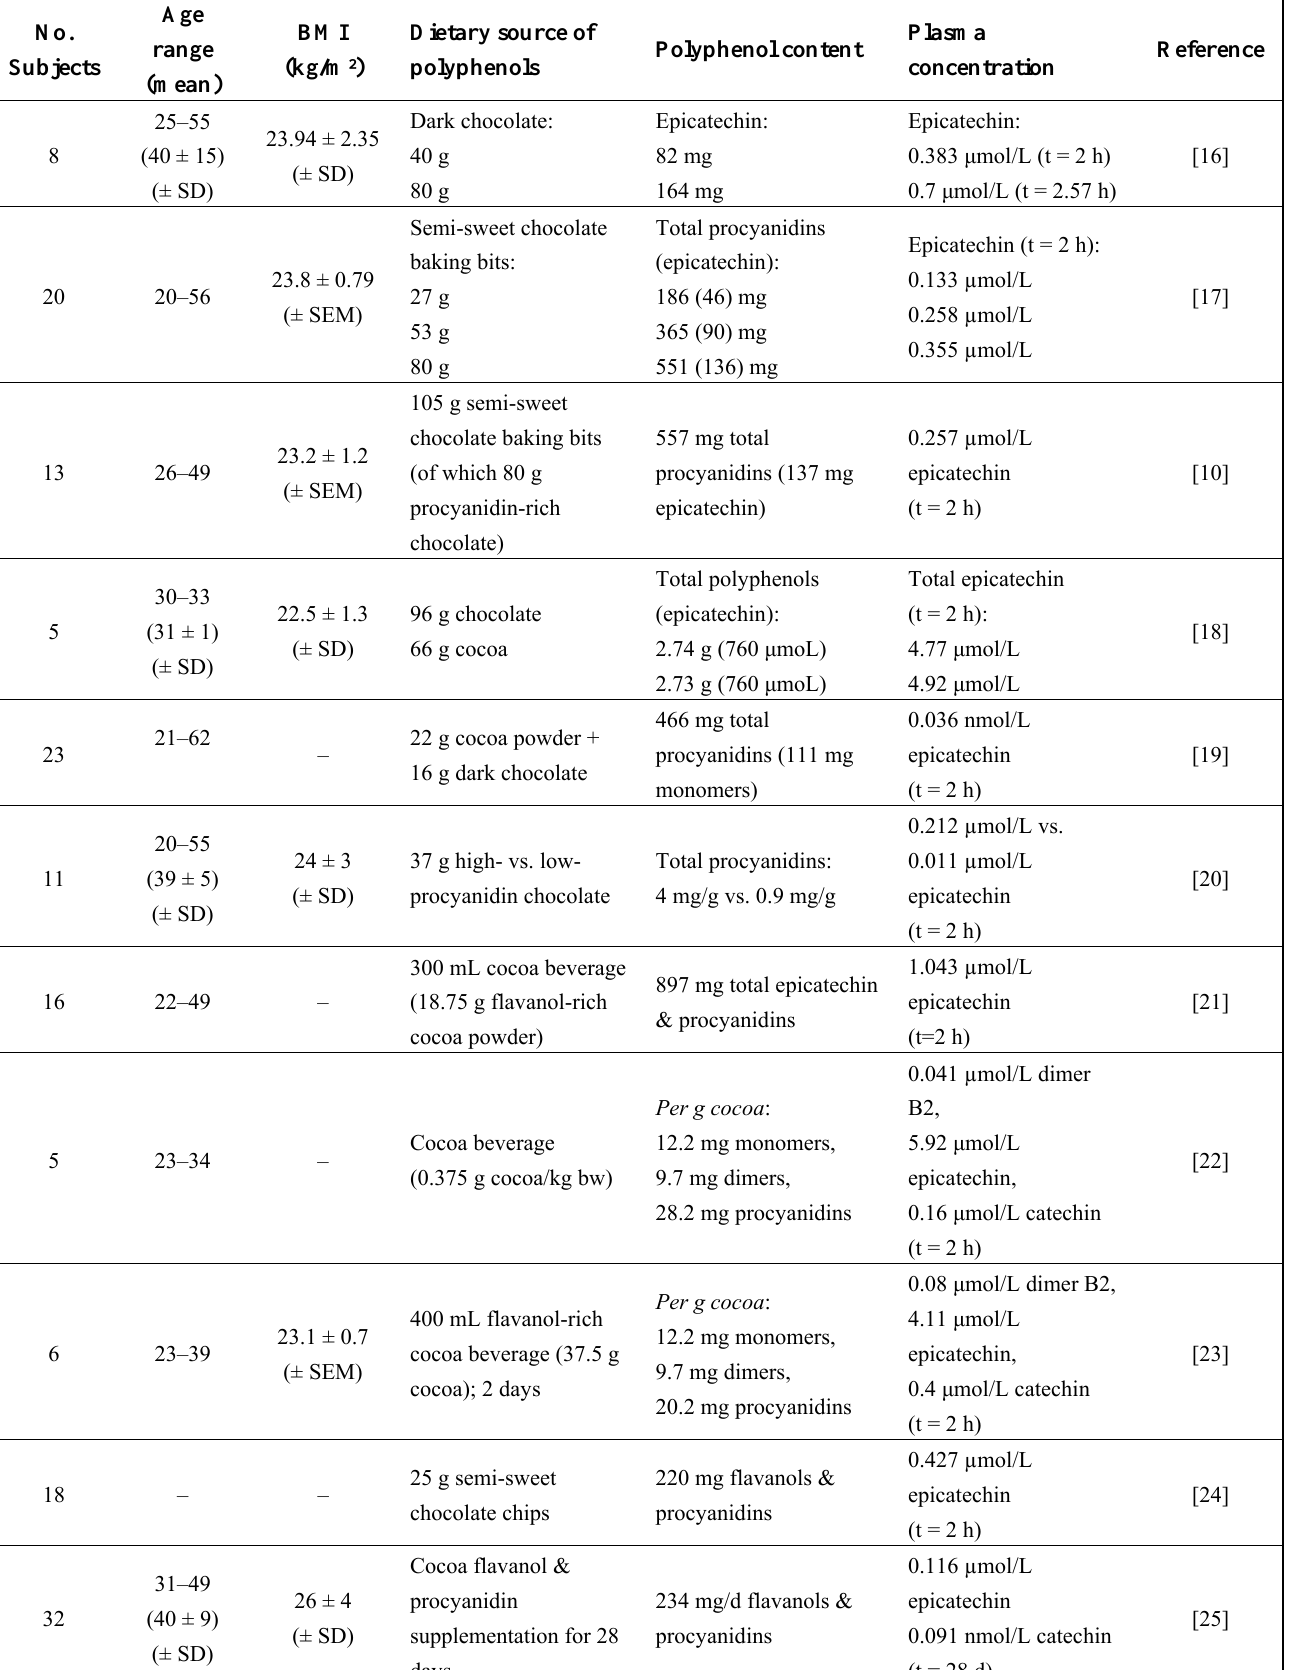
Table 1. Human bioavailability studies on cocoa